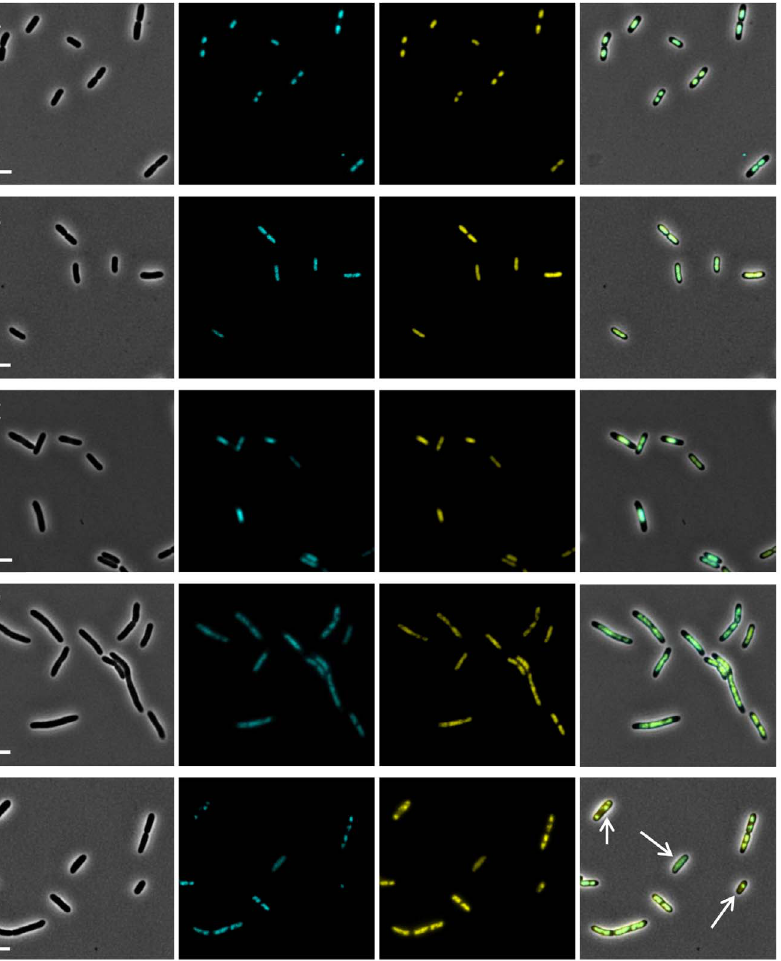
Figure 3. Representative images showing the colocalization of the IscR::YFP protein with the DAPI stained nucleoid in LT2 iscR :: yfp cells stressed with (A) chloramphenicol, (B) rifampicin, (C) nalidixic acid, or (D) mitomycin C. (E) Representative images showing the colocalization of the IscR::YFP protein with the DAPI stained nucleoid in LT2 iscR :: yfp recA1 srl-202 ::Tn 10 cells, in which compromised RecA function leads to cells with an aberrant nucleoid positioning and morphology (indicated with arrows). For each condition, consecutive panels show phase- contrast, DAPI, YFP, and merged images. Scale bars correspond to 5 m m.